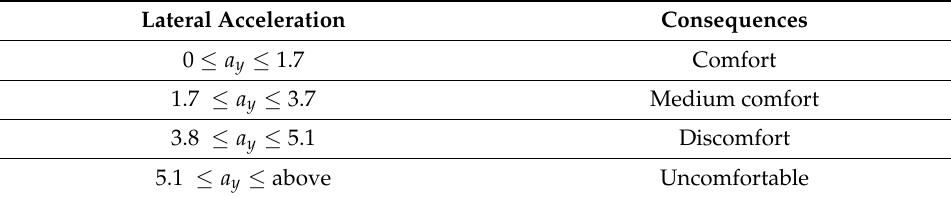
Table 1. Consequences of lateral acceleration and its effects on passengers.